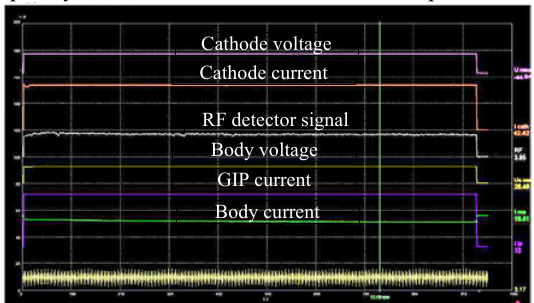
Fig. 2 Signal traces monitored during one of 1MW/1000s pulse